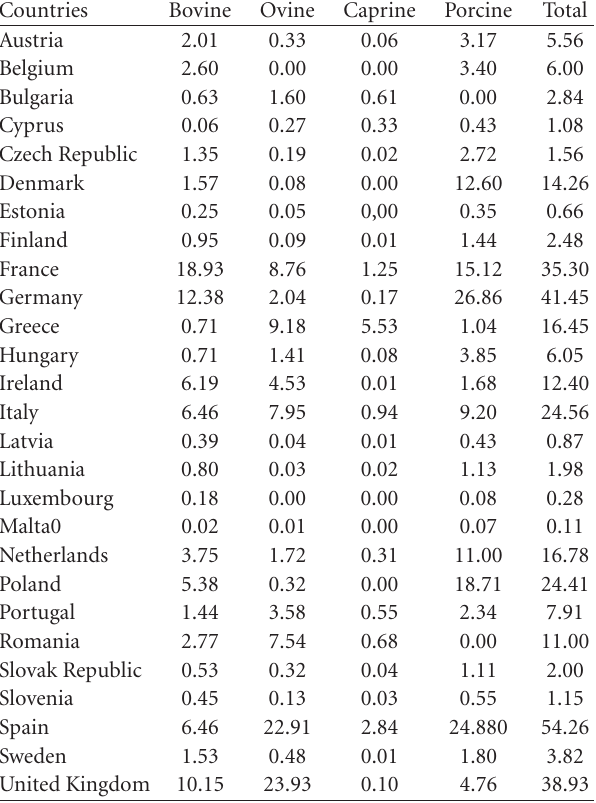
Table 1: EU livestock census (millions of animals) in December 2005.